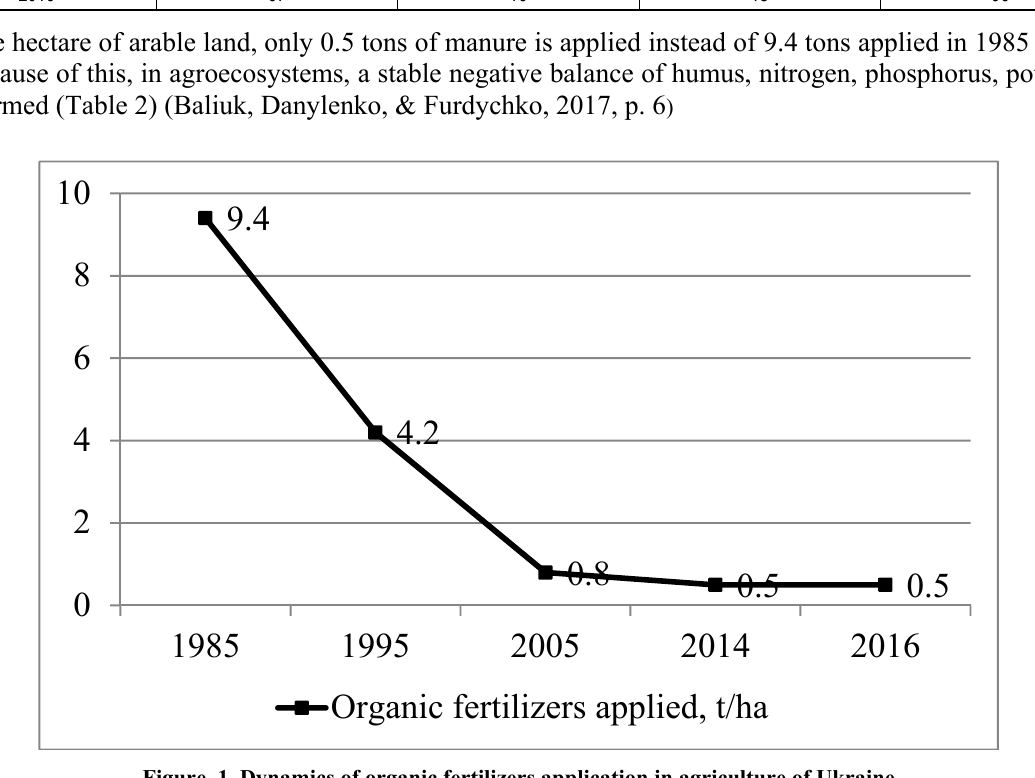
Figure. 1. Dynamics of organic fertilizers application in agriculture of